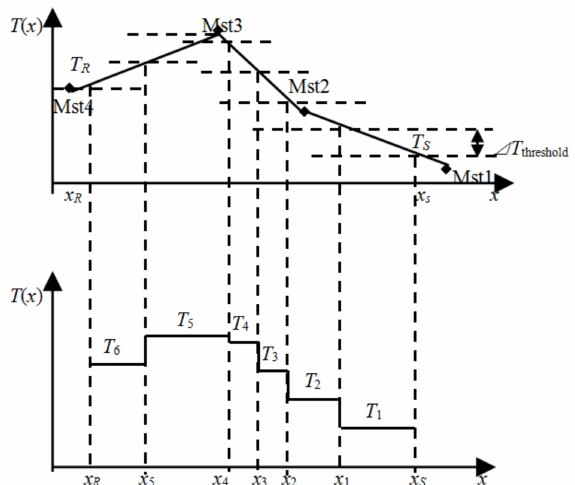
Figure 4. Temperature distribution under the multisegment transmission line model. T :